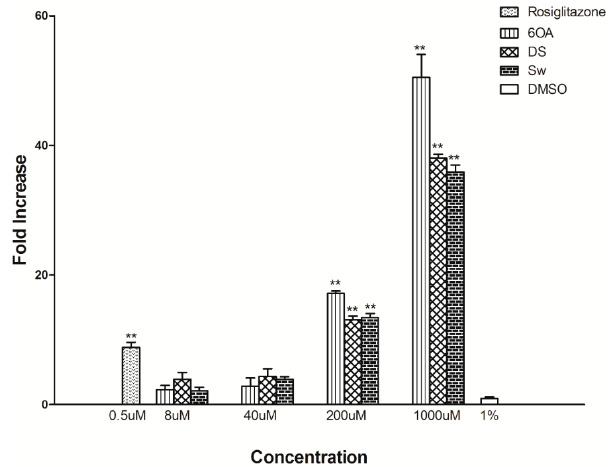
Figure 2. ELISA binding of PPAR γ to different concentrations of the 6- O -acetylswietenolide (6OA), diacetyl swietenolide (DS) and swietenine (Sw) compounds isolated from S. macrophylla seeds. The